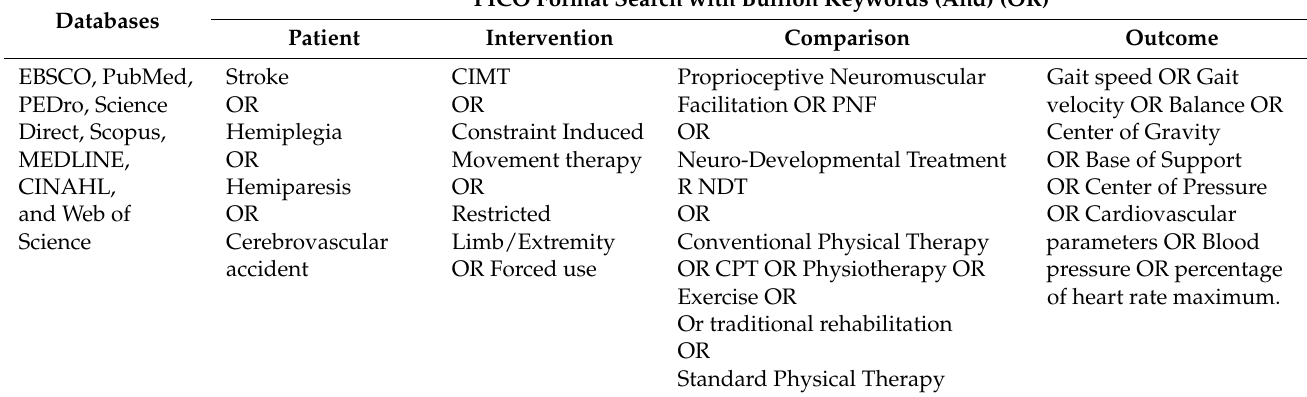
Table 1. Search strategy utilized in the study. PICO Format Search with Bullion Keywords (And) Databases